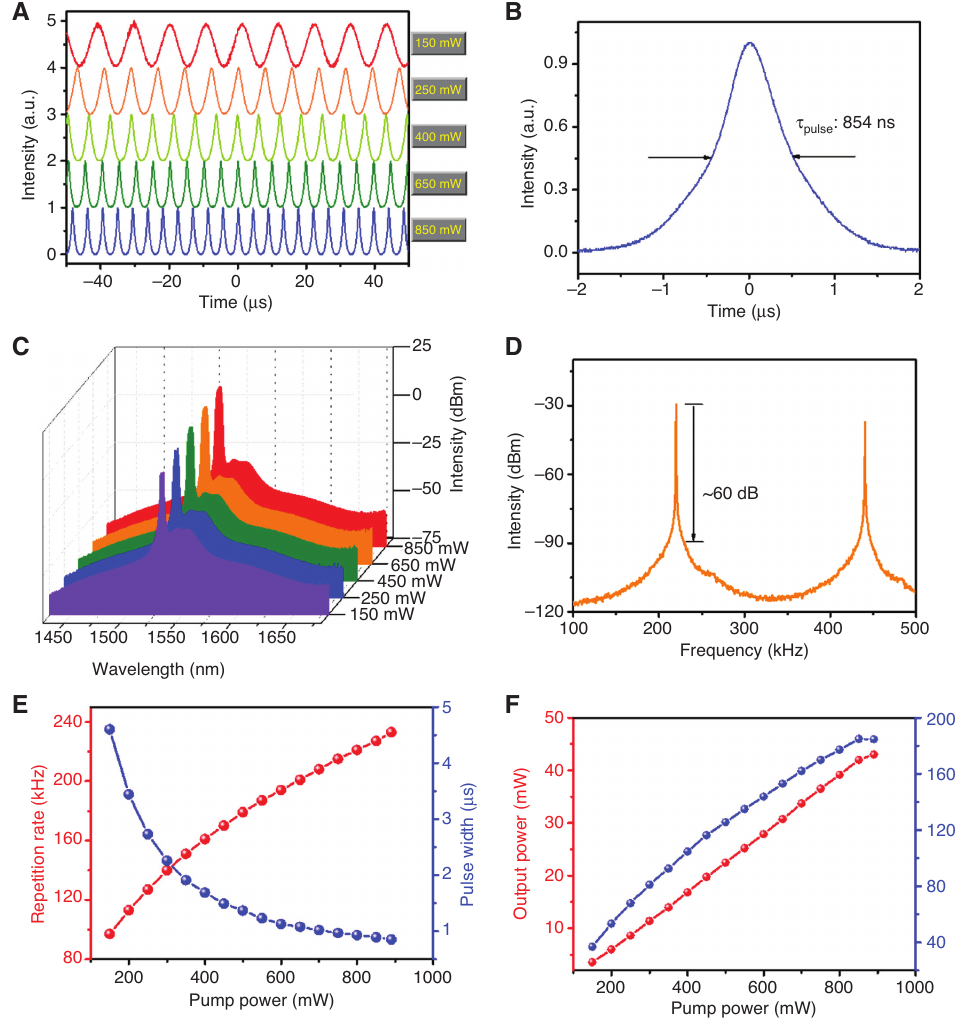
Figure 5: Experimental results. (A) The Q-switched pulse sequence at different pump powers; (B) single pulse duration at the pump power of 890 mW; (C) the optical spectrum; (D) the RF spectrum; (E) relationship of pump power and repetition rate (pulse width); (F) relationship of pump power and output power (pulse energy). Table 1: Comparison of the performances of Q-switched EDF lasers based on different 2D SAs.